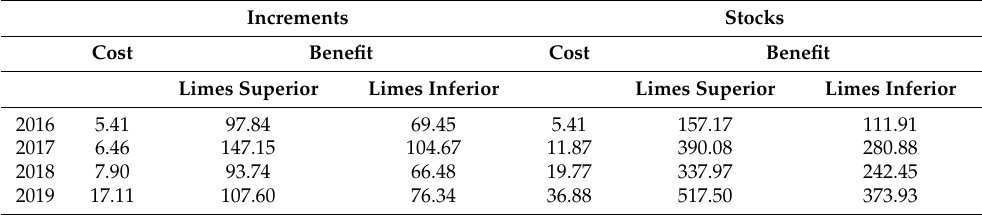
Table 2. The Cost-Benefit of NEV promotion in Beijing from 2016 to 2019. (Unit: 100 million CNY).